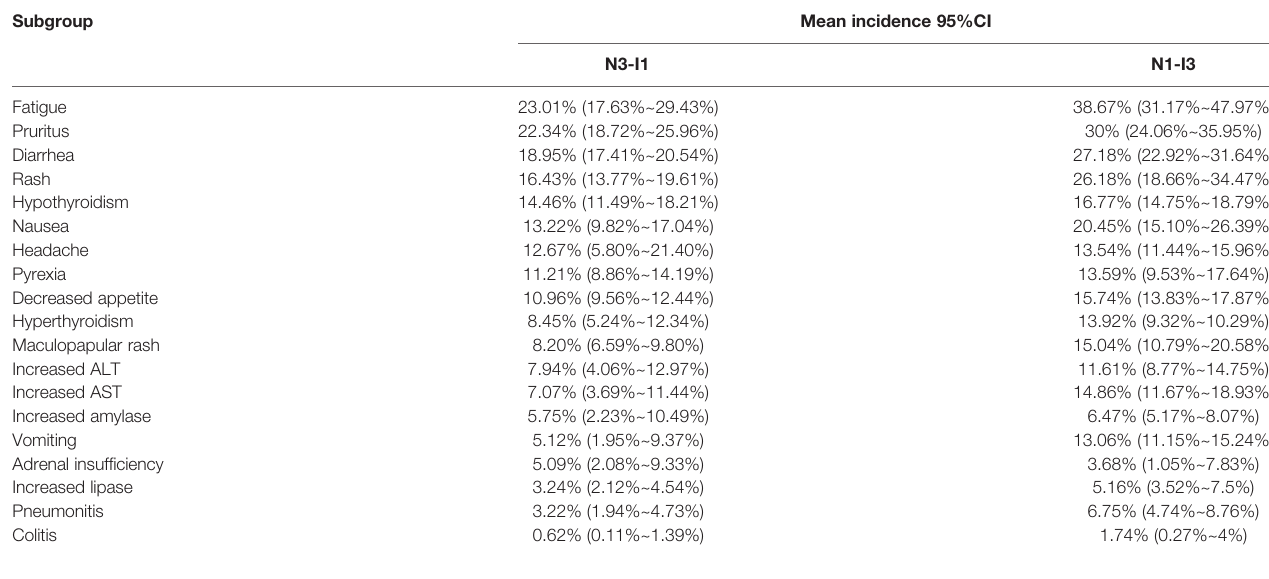
TABLE 2 | Risk ratio of grade 1 and 2 adverse events for N3-I1and N1-I3 subgroup.